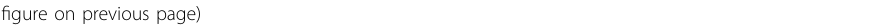
Fig. 3 Effects of miR-24-3p or miR-25-3p on the oscillation of the PER2 protein. The results of real-time bioluminescence recordings are represented in raw and detrended data formats. a , b Per2::Luc KI MEFs were transfected with miR-24-3p or miR-25-3p mimics for gain-of-function studies. c , d For loss-of-function studies, miR-24-3p or miR-25-3p inhibitors were transfected into the Per2::Luc KI MEFs. Bioluminescence patterns were recorded for 3 days and normalized by the control group. e Relative periods and area under curve were calculated from the raw data, which is presented in bar graphs. f , g Per2 promoter-driven luciferase (Per2pro-Luc) mutants were transfected into NIH3T3 fi broblasts with an miR-24-3p inhibitor, miR-25-3p inhibitor, or miR-control oligomer. Data are presented as the means ± SE ( n = 4), and signi fi cance was assessed by one-way ANOVA, * p < 0.01 compared to the control